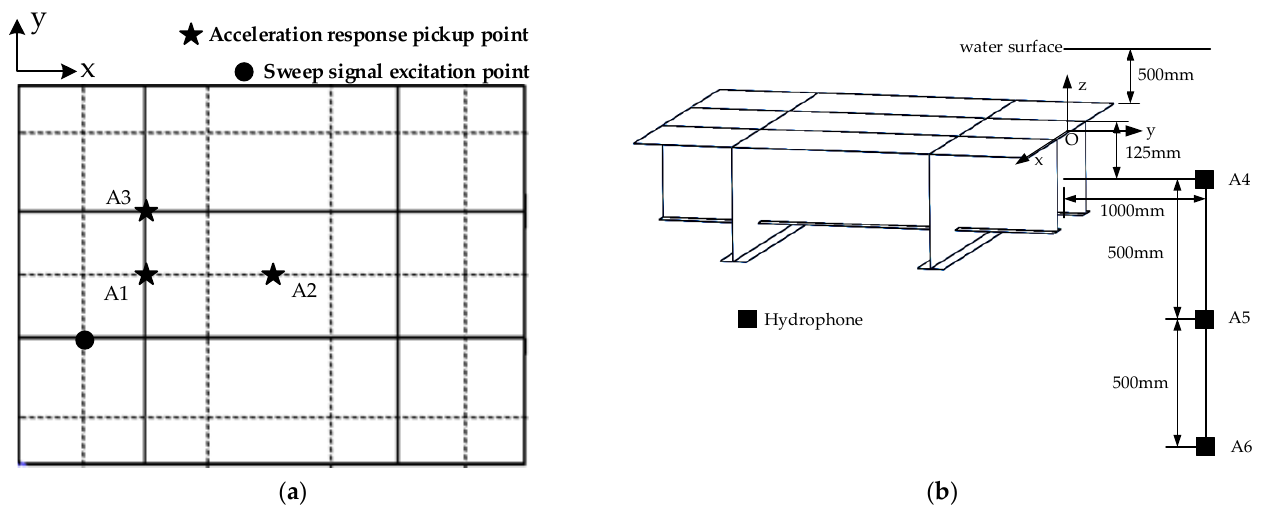
Figure 8. The layout of the underwater vibration and acoustic radiation measuring points. ( a ) The layout of vibration measurement points; ( b ) the layout of acoustic radiation measurement points.